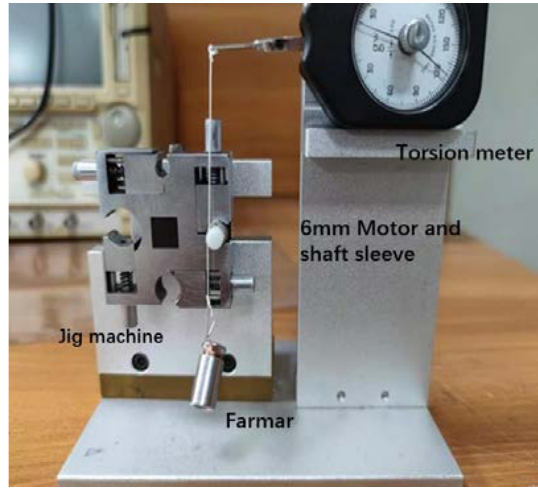
Figure 12. Structure diagram of torque test bench.